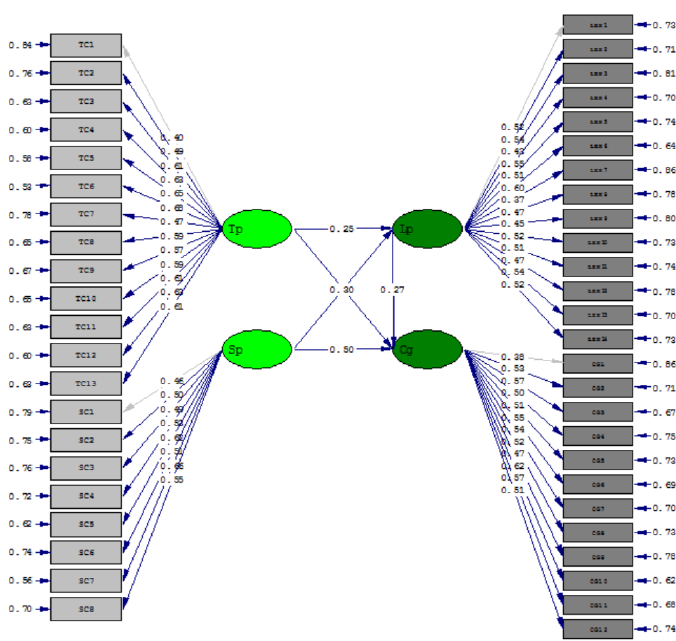
Figure 3. Final model of the 47-item structure (TP = Teaching presence; SP = Social presence; Lp=Learning presence; Cg= Cognitive presence).